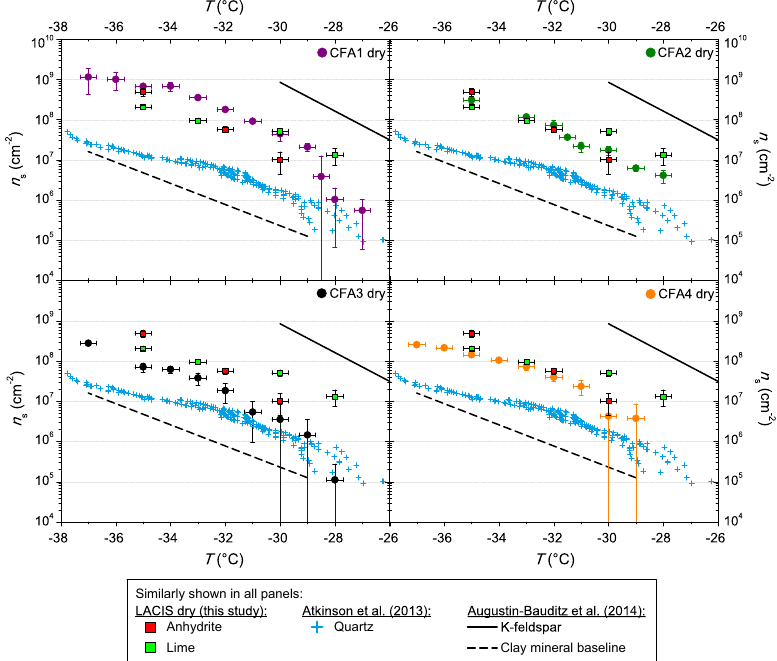
Figure 2. n s from LACIS measurements with dry-generated CFA particles. Measurements with dry-generated anhydrite and quicklime are included for comparison in all panels but are (in contrast to CFA) not corrected with respect to multiple charges. Measurements with quartz shown in all panels are taken from Atkinson et al. (2013). Fit lines to LACIS measurements with a K-feldspar sample and different kinds of mineral dust coated with sulfuric acid (clay mineral baseline) are taken from Augustin-Bauditz et al.